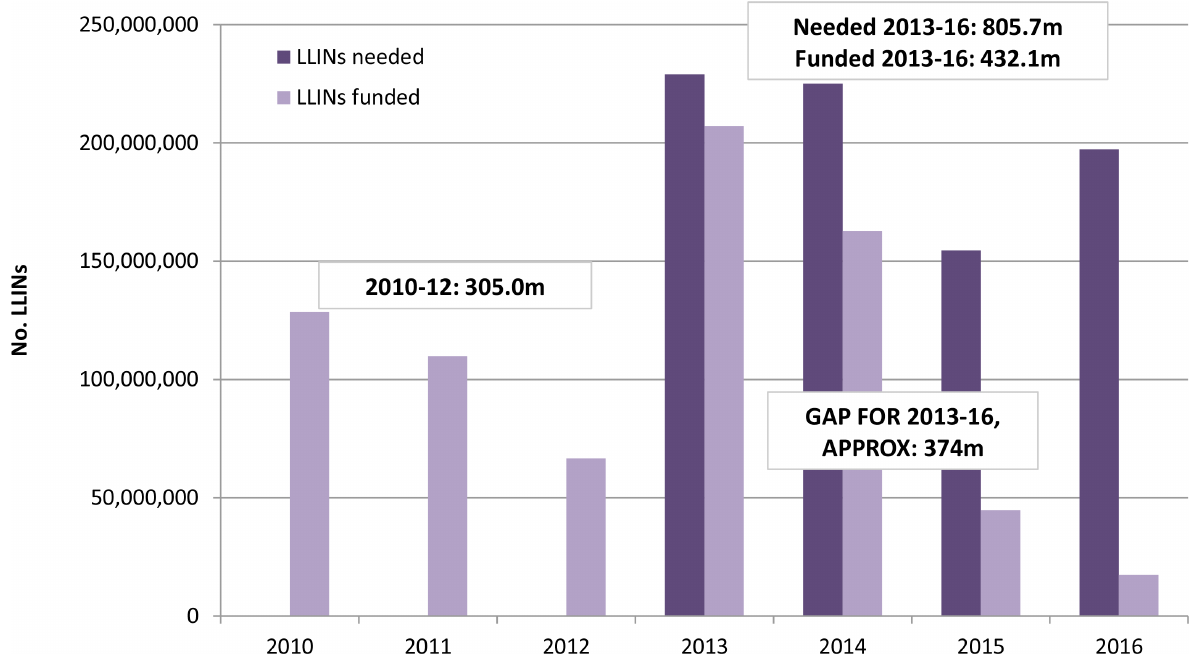
Figure 1. Total LLINs needed and funded for 40 malaria-endemic countries in sub-Saharan Africa (2010 – 2016).